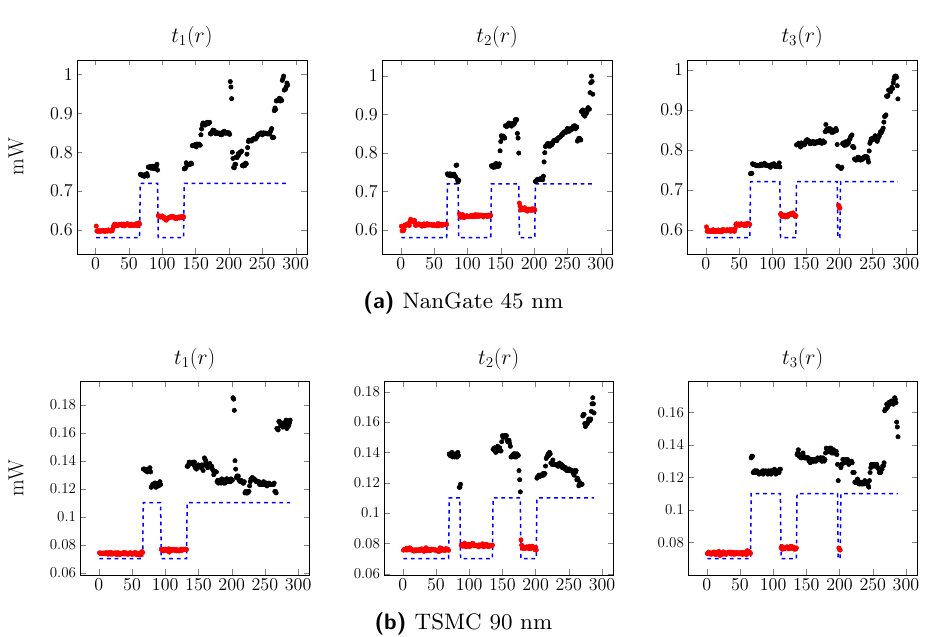
Figure 4: Power measurements for all the perfect unrolled strand trees for two cell library processes. The red data points indicate unrolled strand equations which correspond to perfect trees. The dashed blue line signifies the transition boundaries between perfect and imperfect trees, i.e., low points represent perfect unrolled strand trees while high points correspond to imperfect trees.